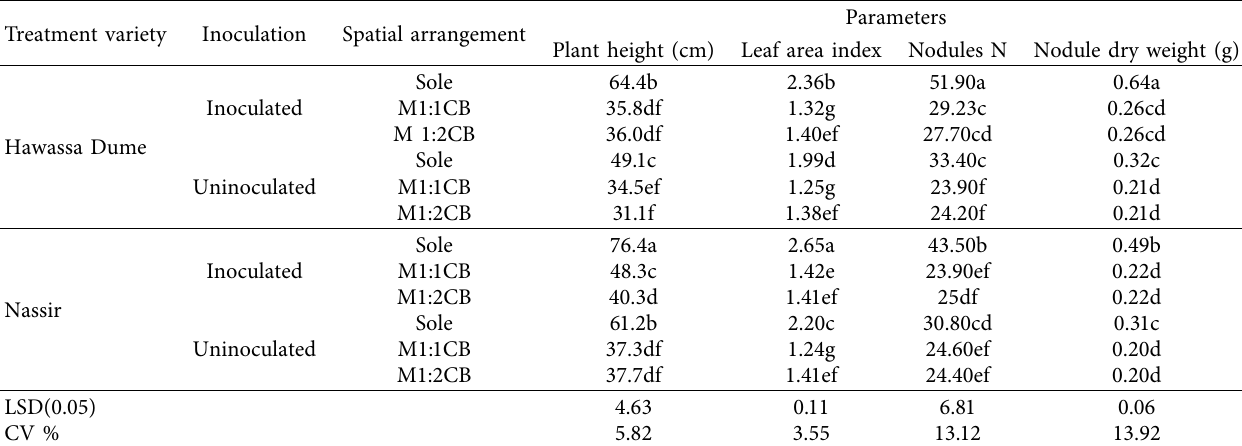
Table 7: Interaction efects of variety, inoculation, and spatial arrangement on growth and nodules of common bean. Treatment variety